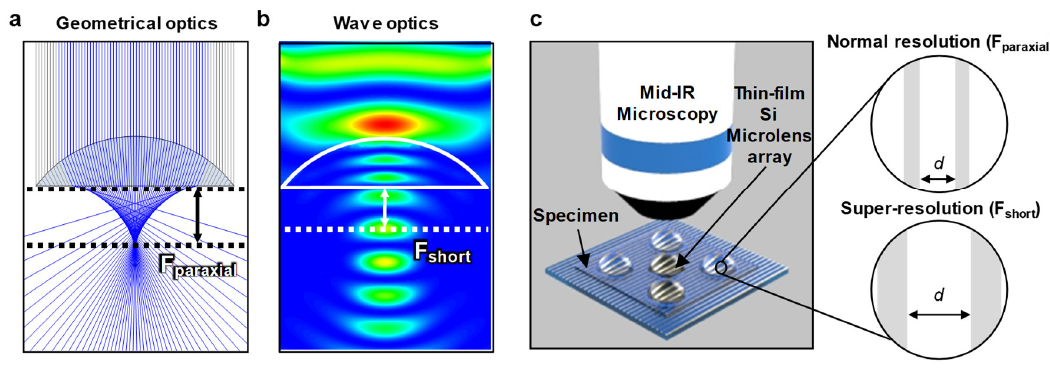
Figure 1. ( a ) Ray-tracing simulation and ( b ) wave optics simulation result. ( c ) (left)